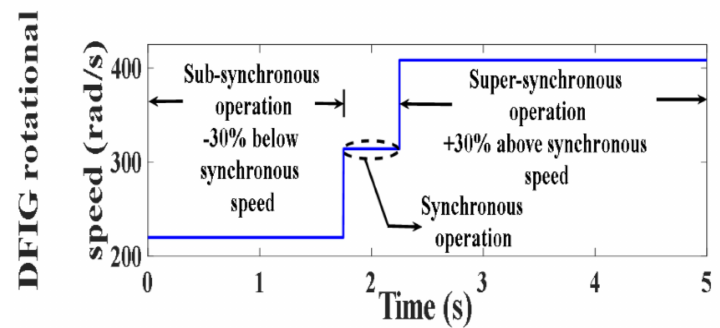
Figure 51. Prime mover operating speeds